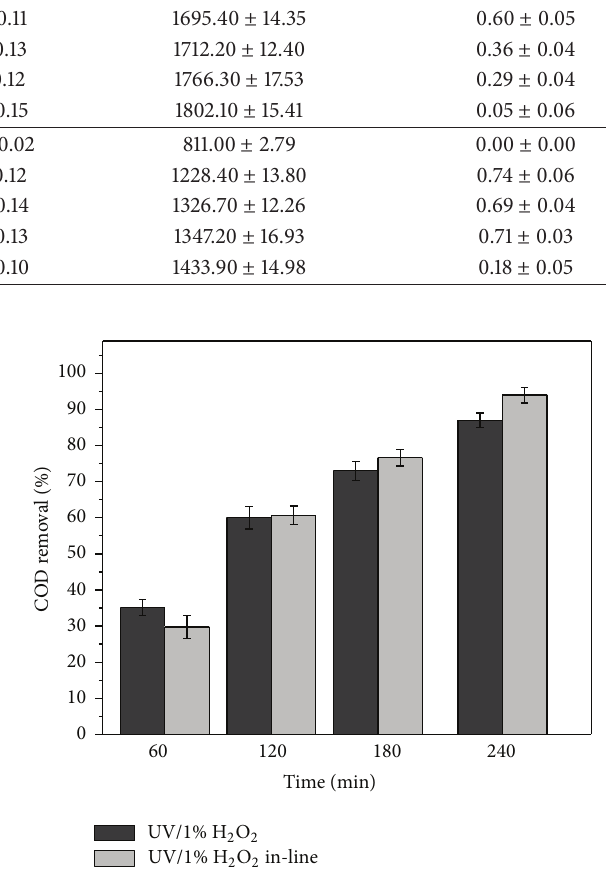
Figure 12: Effect of the in-line hydrogen peroxide addition on COD removal. Experimental conditions: initial pH of 10, UV/1% H 2 O 2 , and 60 ∘